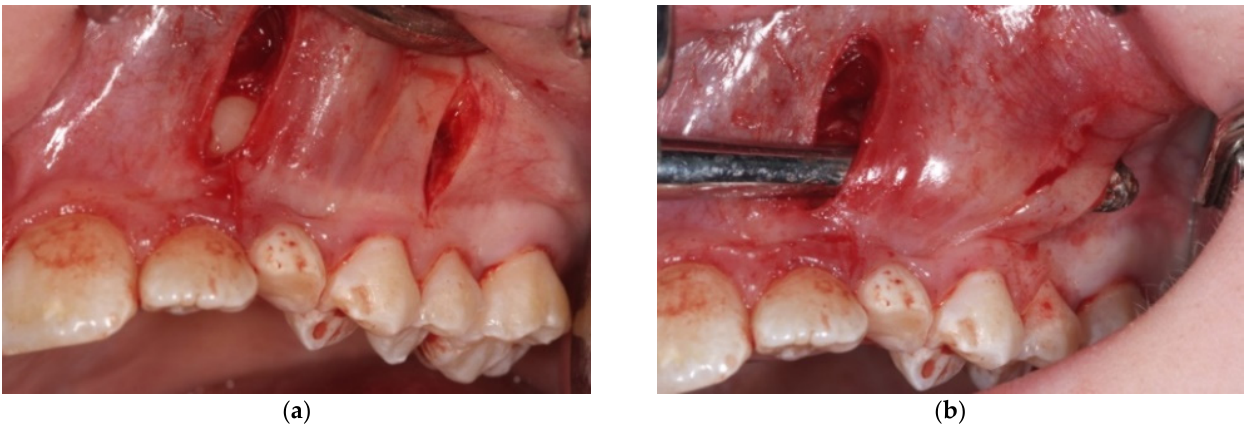
Figure 4. A second vertical incision is made between the first and second premolar ( a ) and connected to the first one through a sub-periosteal tunnel ( b ).